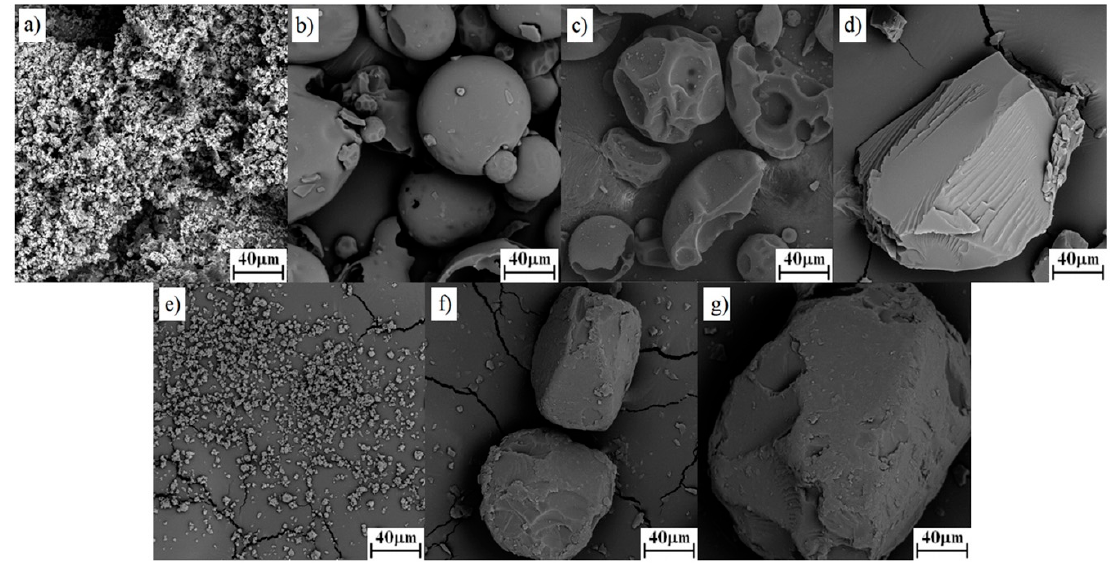
Figure 2. Morphology images of TAD, K64, their PM and SDs: ( a ) pure TAD, ( b ) pure K64, ( c ) TAD-K64 PM, ( d ) TAD-K64 SD (SE), ( e ) TAD-K64 SD (SPD), ( f ) TAD-K64 SD (HME125) and ( g ) TAD-K64 SD (HME250).